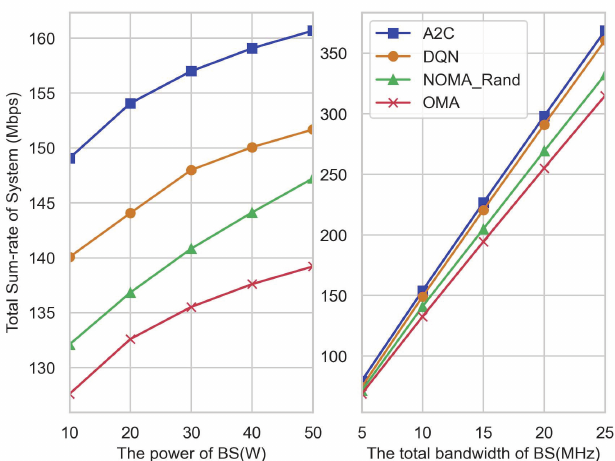
Figure 9. Different BS power and